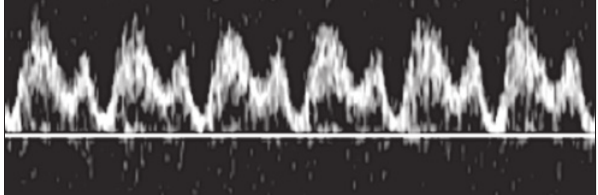
Figure-2: Pulsed-wave Doppler image of a diphasic waveform of a ductus venosus.